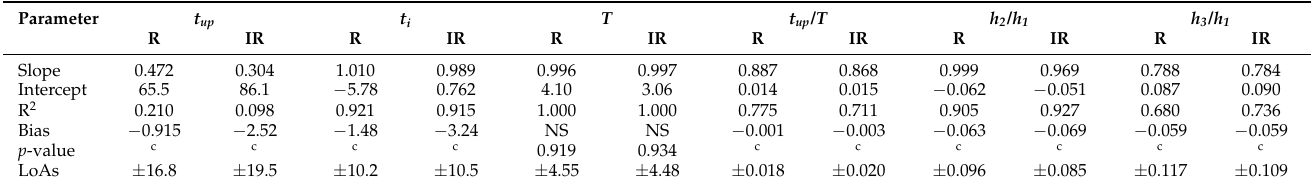
Table 7. Results of the regression, correlation, and Bland–Altman analyses that were carried out to compare the morphological parameters of PW signals provided by FCG and PPG sensors for all subjects. Intercept, bias, and LoAs for t up , t i , and T are expressed in milliseconds. Non-significant bias is indicated as